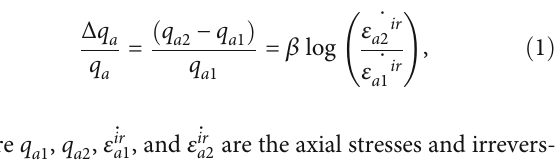
- σ ) – ε summary curves ( σ 1 3 a